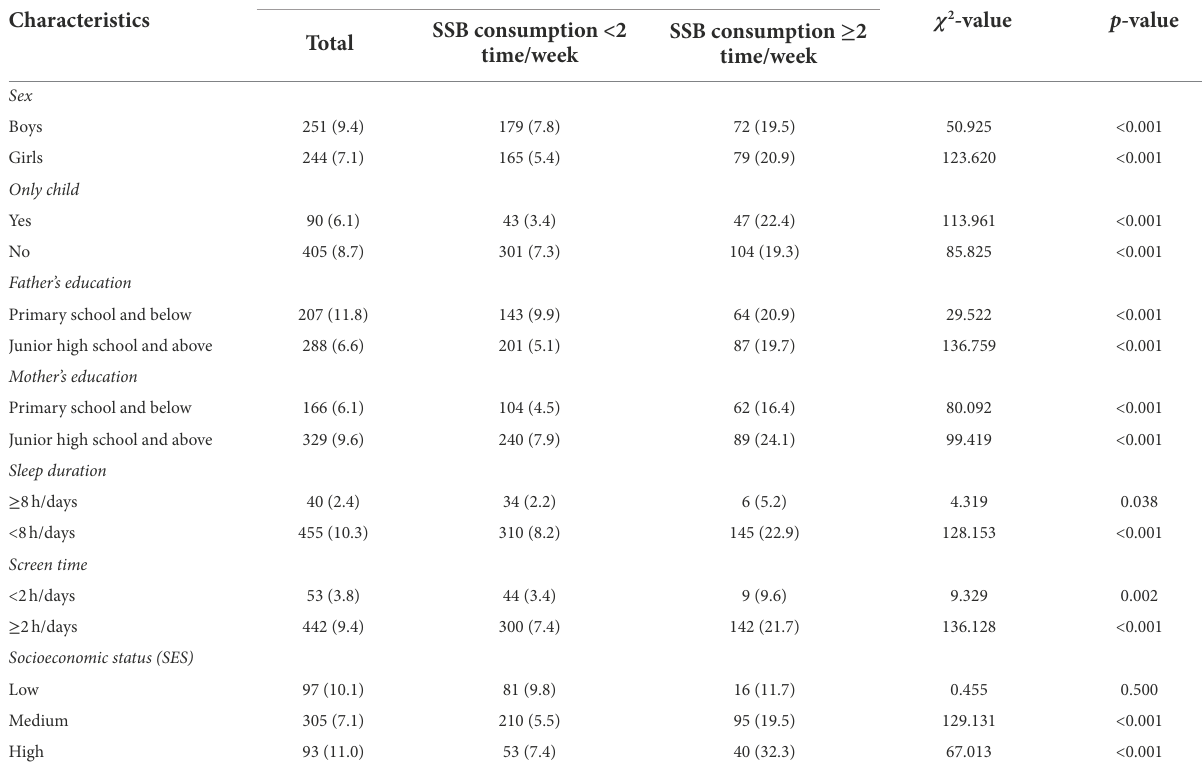
TABLE 1 Comparison of SSB consumption status of college students with different characteristics in China.